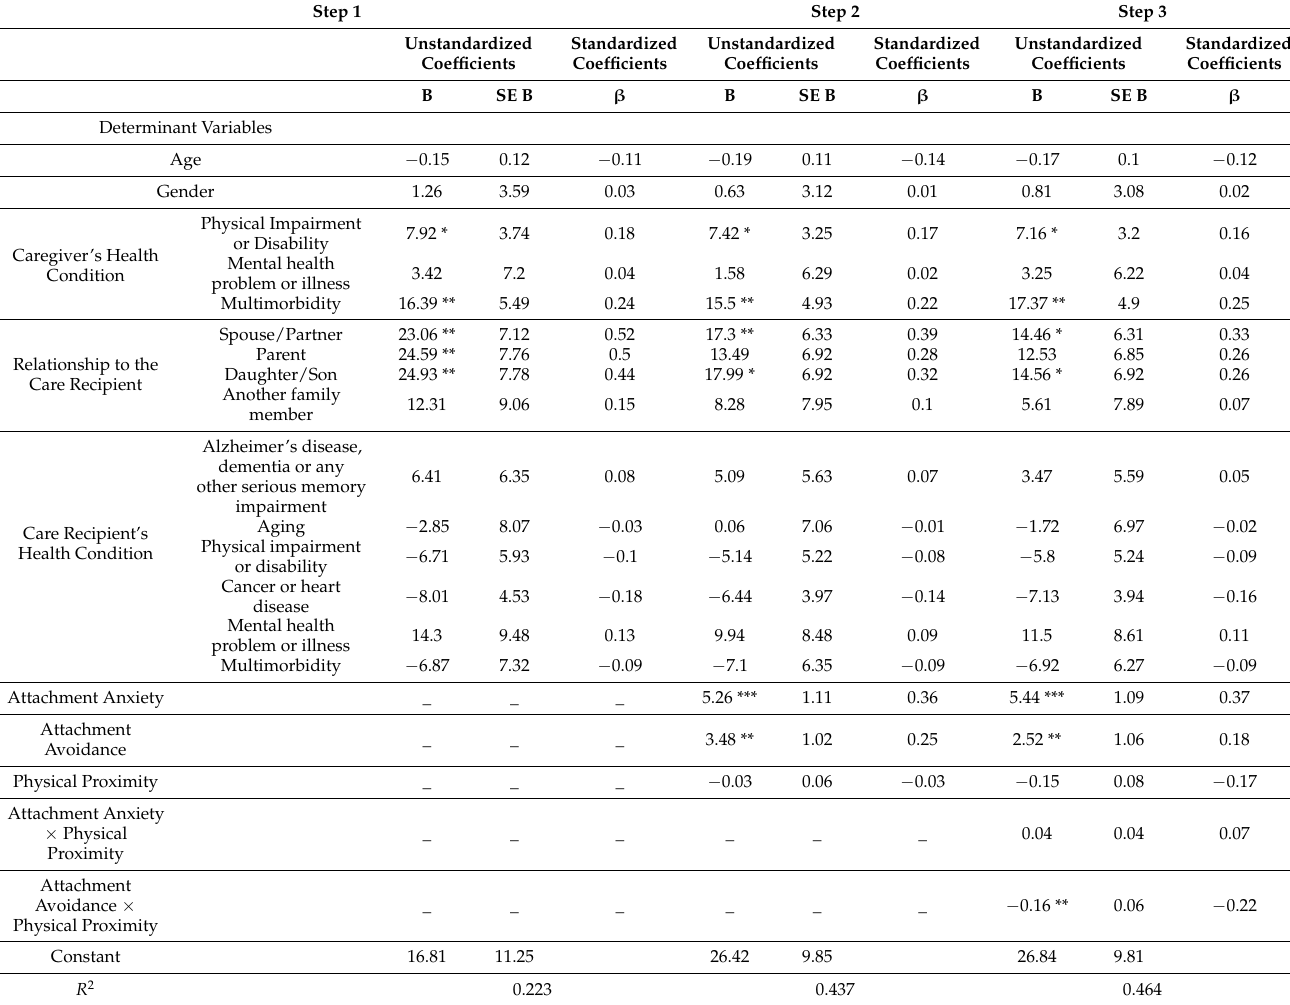
Table 4. Summary of multiple regression model for caregiver